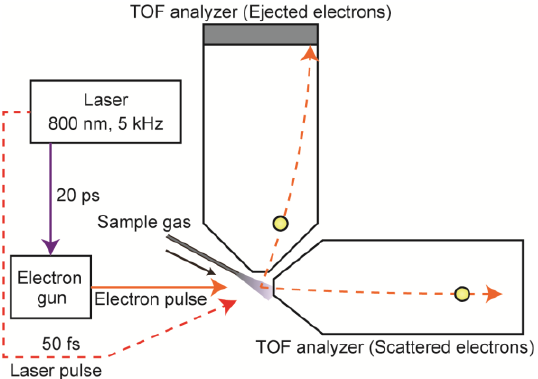
Fig. 1. Schematic of the apparatus for the measurements of LAEII processes induced by femtosecond intense laser